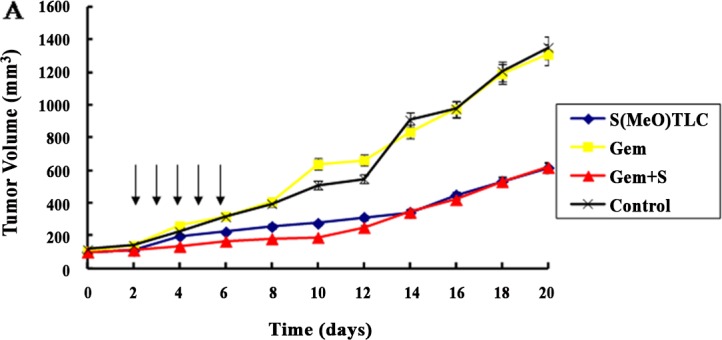
Anticancer activity of S(MeO)TLC in subcutaneous xenograft tumors.A. After successful establishment of subcutaneous xenograft tumors, DMSO (vehicle control), 20 mg/kg S(MeO)TLC, 50 mg/kg Gemcitabine or both(S(MeO)TLC + GEM) were administered intraperitoneally daily for 5 days (arrows). Tumor volumes were measured every other day. B. The mean body weights of mice were assessed every other day. There is no significant difference among three groups (P>0.05).